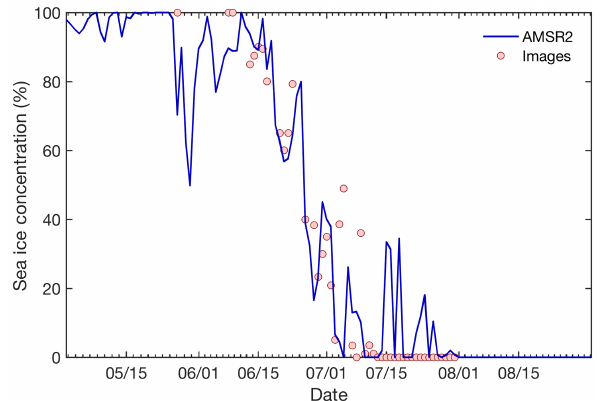
Figure 4. Sea ice concentration from the AMSR2 SIC product and the mean daily average from satellite and in situ